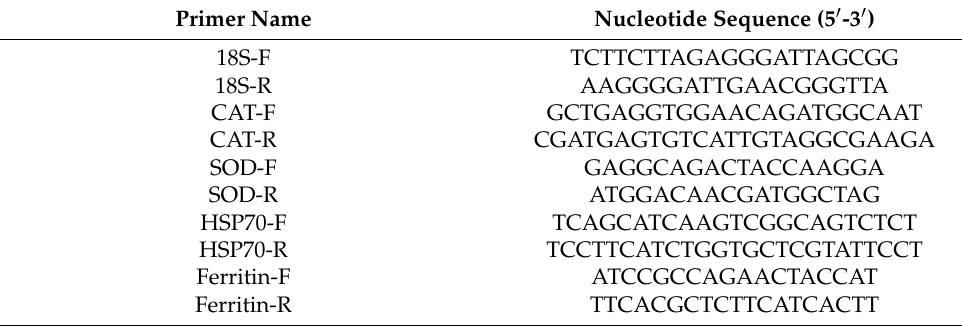
Table 1. Primer pairs used in qPCR.